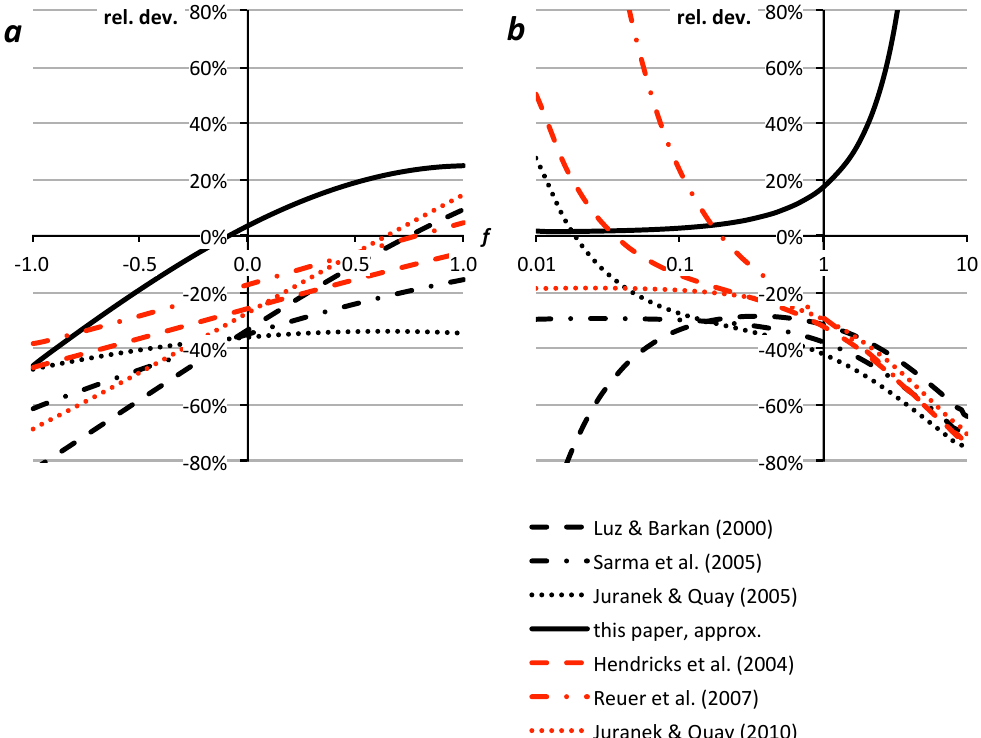
Fig. 3. Relative deviation of g for different calculation methods (Table 3). Panel (a) corresponds to g = 0 . 4 and a range of f from − 1.0 to +1.0 (negative values correspond to net heterotrophy, positive value to net autotrophy). Panel (b) corresponds to f = 0 . 1 and range of g from 0.01 to 10 (logarithmic axis). Black curves correspond to calculation methods based on Eq. (1). Red curves correspond to iterative